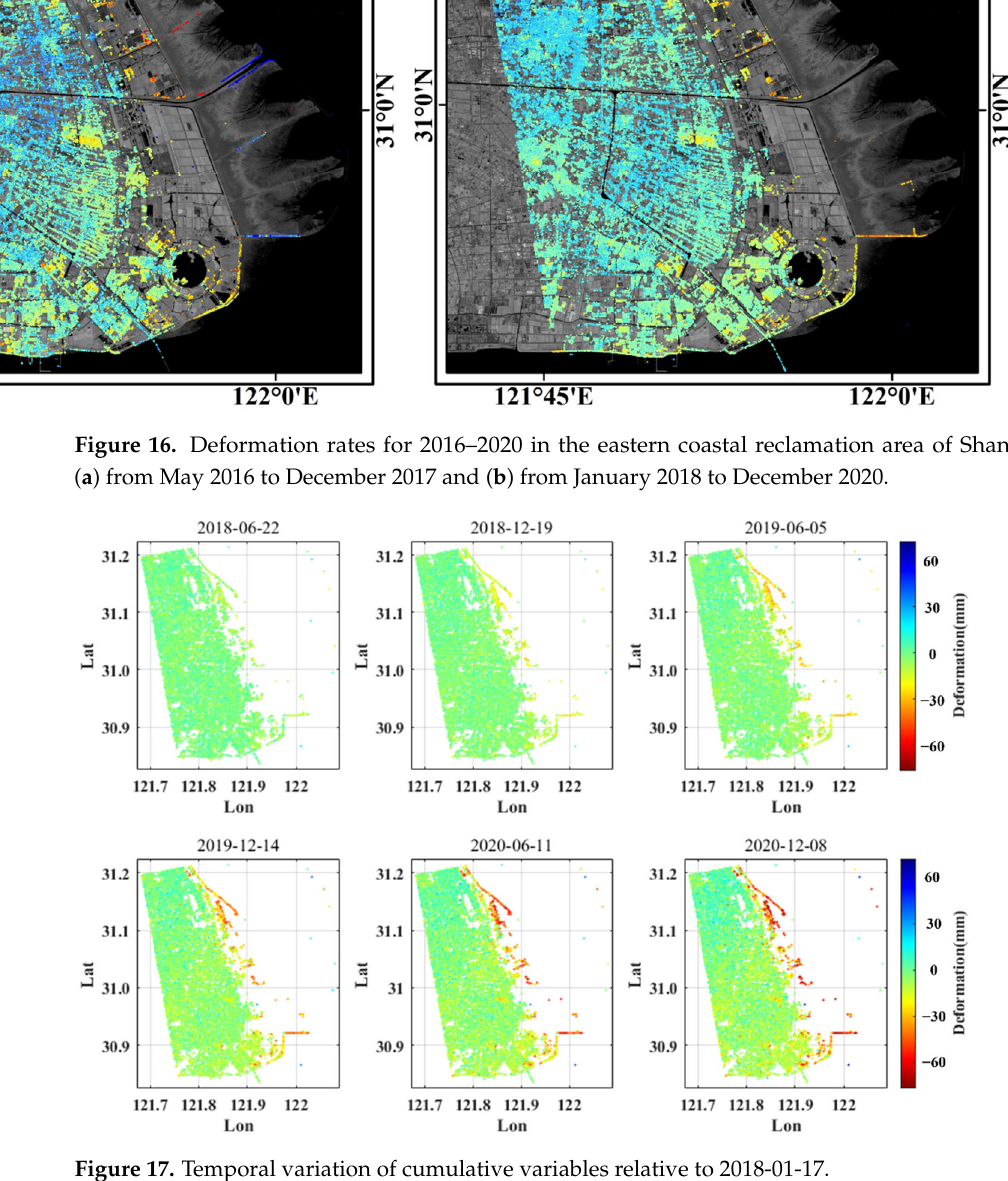
Figure 17. Temporal variation of cumulative variables relative to 2018 ‐ 01 ‐ 17.